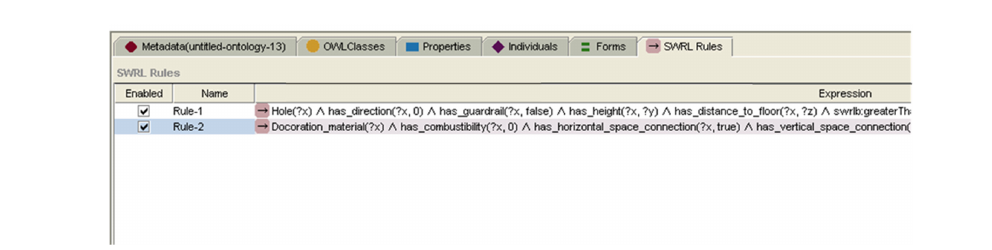
Figure 6. Vertical hole rule frame.